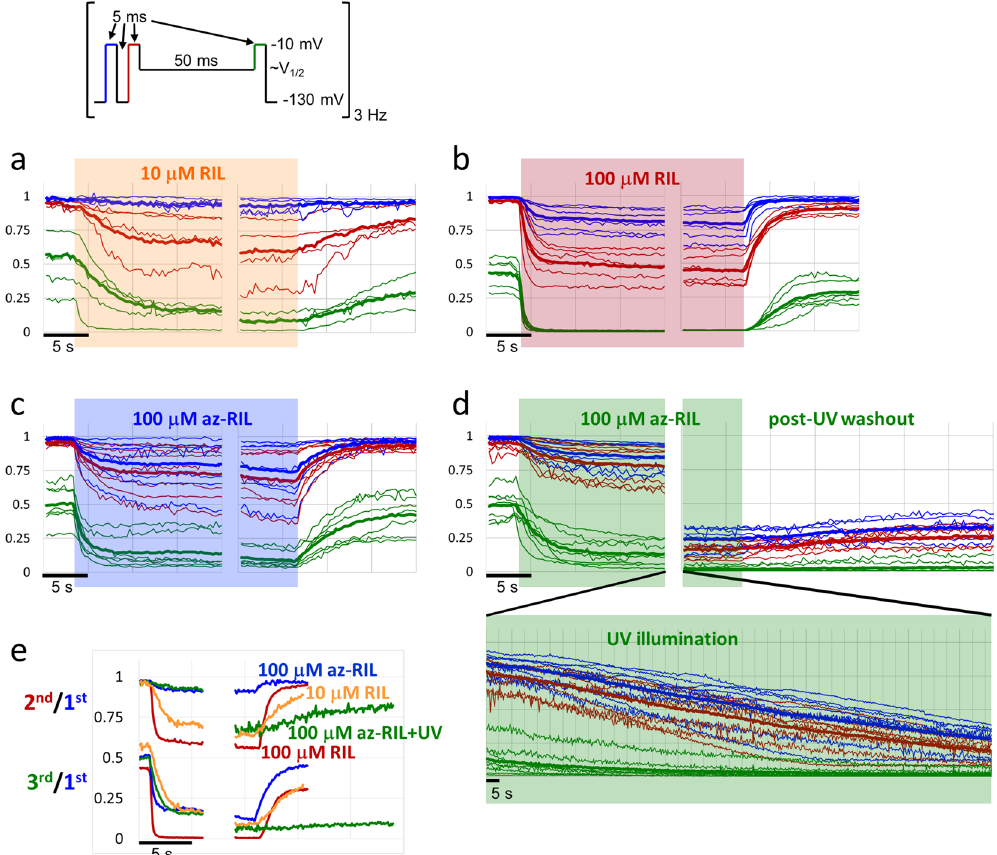
Figure 5. Onset and offset of drug effects in the 3PT protocol. Plots of peak amplitudes for the 1 st , 2 nd , and 3 rd pulse-evoked currents are shown in blue, red and green lines, respectively. Thin lines show measurements from individual cells, thick lines show averages. Recordings from individual cells were aligned to the moment of wash-in and wash-out for comparability, with 0 to 767 s of recording not shown between the onset and offset. Ten control trains (3.3 s) are shown before drug applications, and the last 20 trains (6.6 s) of drug application before wash-out. ( a ) 100 µ M riluzole, ( b) 10 µ M riluzole, ( c ) 100 µ M azido-riluzole, ( d ) 100 µ M azido-riluzole with UV irradiation (shown on a contracted time scale below onset and offset). ( e) Plot of 2 nd /1 st pulse-evoked (upper curves) and 3 rd /1 st pulse-evoked (lower curves) amplitude ratios for the onset and offset of: 10 µ M riluzole (yellow lines), 100 µ M riluzole (red lines), 100 µ M azido-riluzole (blue lines), and 100 µ M azido-riluzole with ~3 min UV irradiation (green lines) between onset and